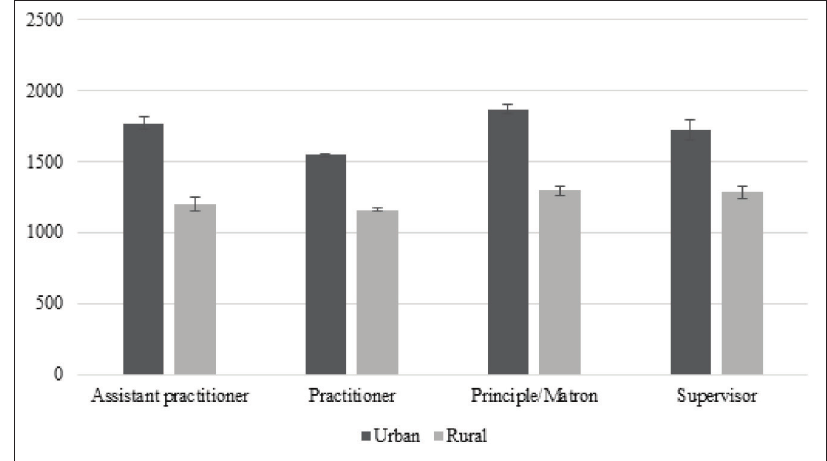
Figure 7: Average monthly salary in rural and urban areas (in Rand) (Source: Economic Policy Research Institute 2014)